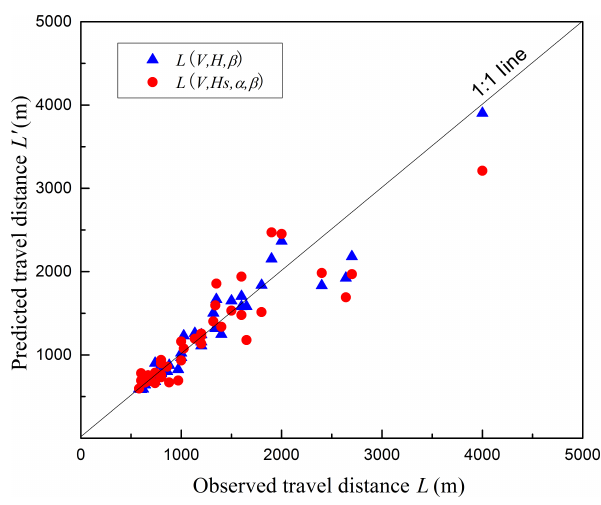
Figure 9. The comparison between observed and predicted travel distance for the two multivariate regression models.